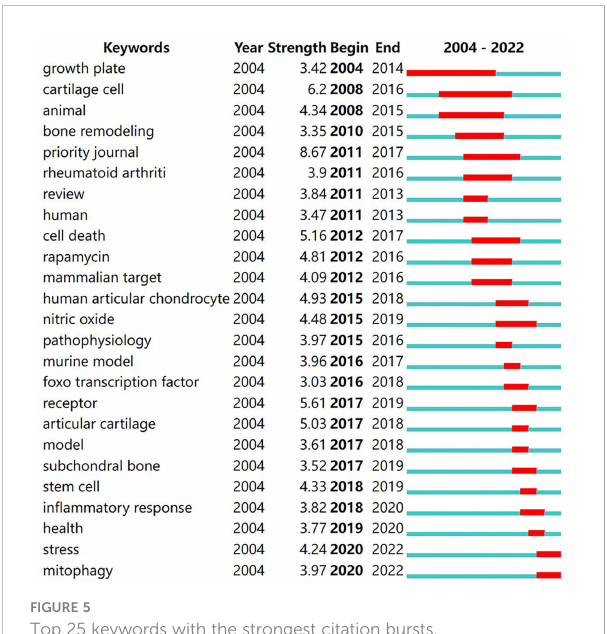
FIGURE 5 Top 25 keywords with the strongest citation